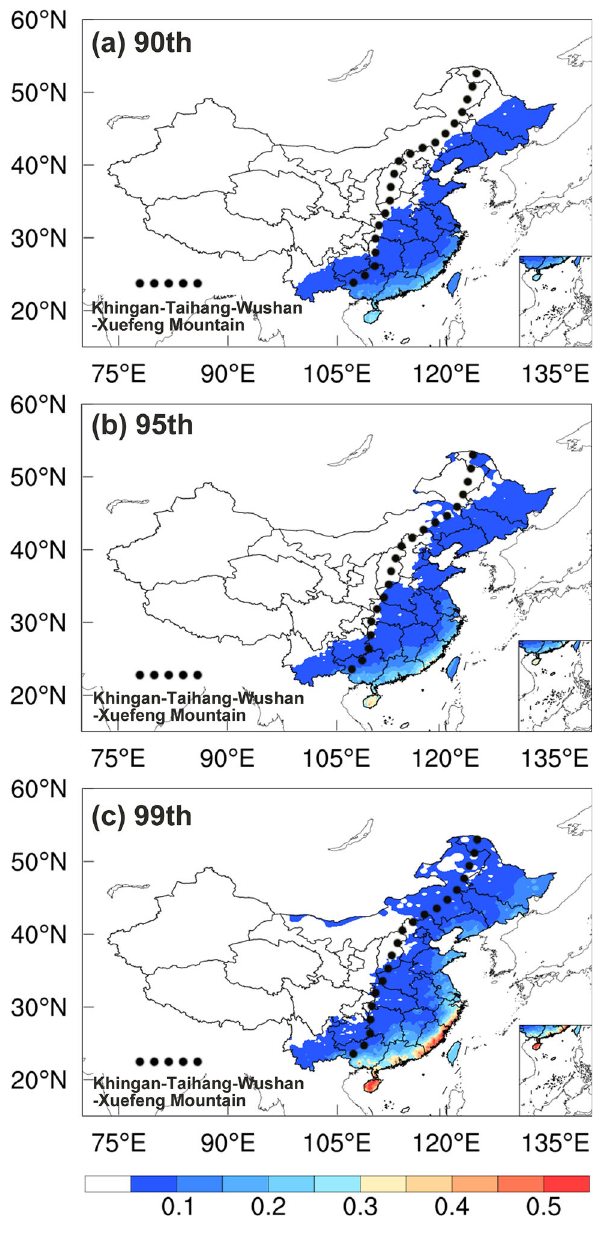
Fig. 4 Contributions of tropical cyclones (TCs) to extreme precip- itation obtained by peak-over-threshold (POT) sampling with 90th ( a ), 95th ( b ), and 99th ( c ) percentile of the precipitation distribution as thresholds in the mainland of